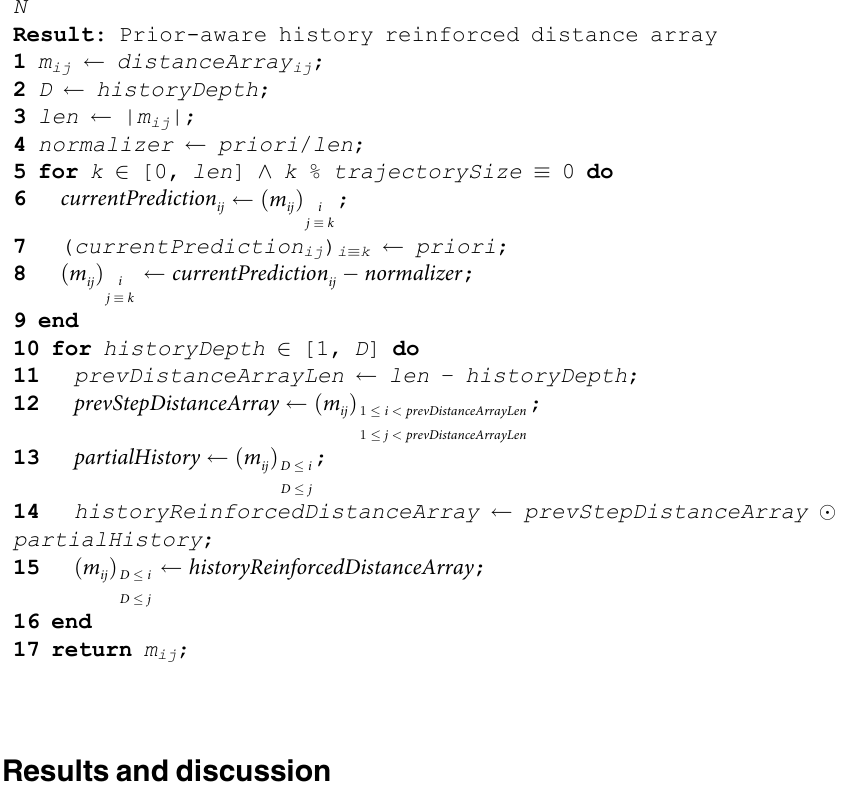
Algorithm 3 : Naive history with a weak